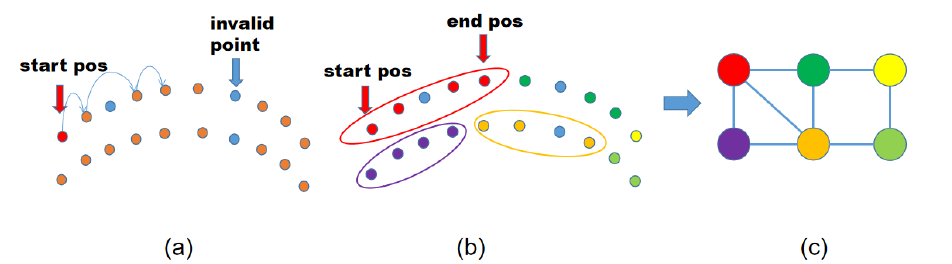
Figure 6. ( a ) When an invalid point (blue) was encountered during the first segmentation, skip and continue searching. ( b ) The segmentation results are expressed in different colors, and the node mainly records the start position and end position. The nodes of adjacent channels have the same horizontal angle of the point cloud; they are connected on the set graph. ( c ) The red node connects the purple and orange nodes.